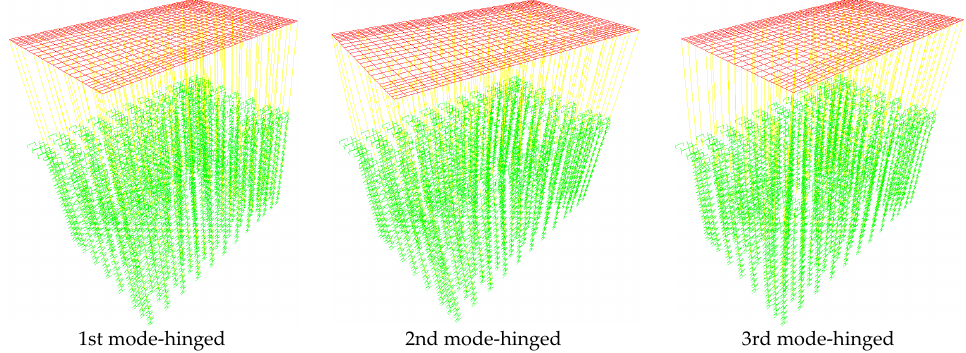
Figure 4. First three mode shapes of the model assuming a fixed and hinged connection between the piles and the reinforced concrete plate of the platform. Table 2. First six eigenvalues and natural periods of the model assuming a fixed and hinged connection between the piles and the reinforced concrete plate of the platform. Fixed Mode